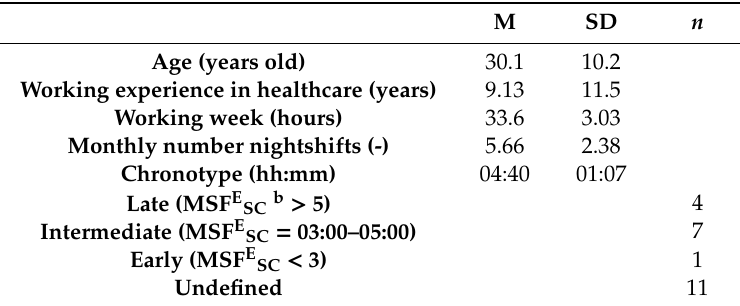
Table 2. Demographics of participants ( N =